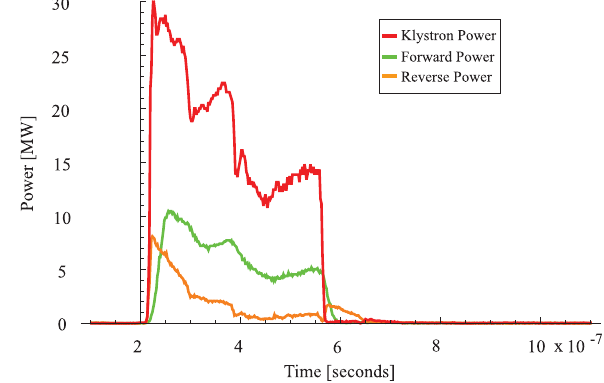
FIG. 13. Peak power meter trace for klystron signals: klystron output power, structure forward, and reverse power traces. After filling, the forward power into the structure was 5.0 MW for 170 ns for this shot.